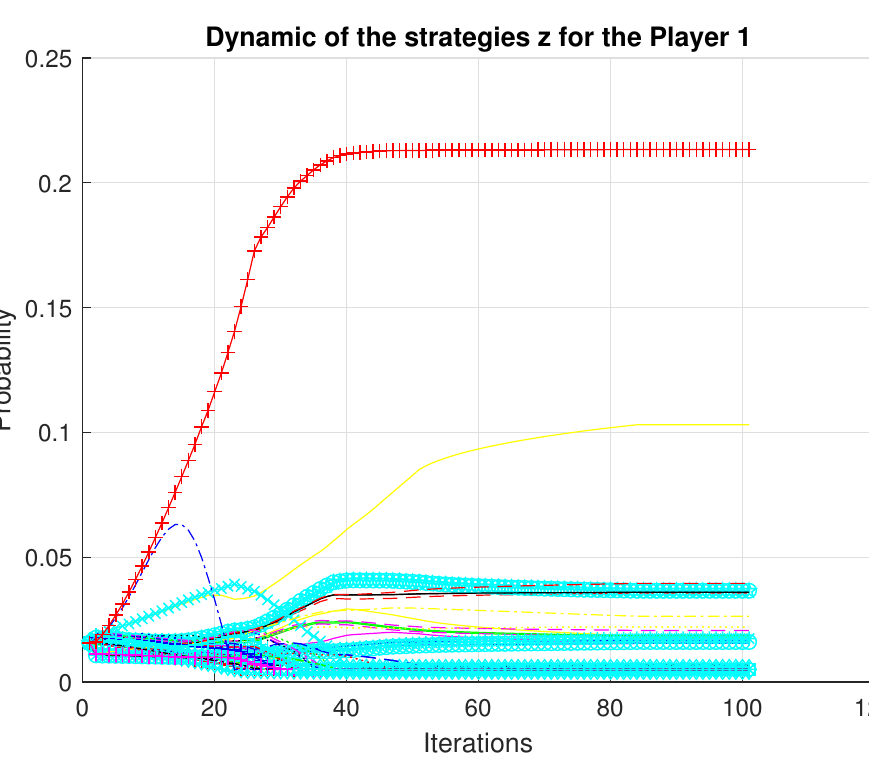
Figure 1. Convergence of strategies z imkk (cid:48) for player